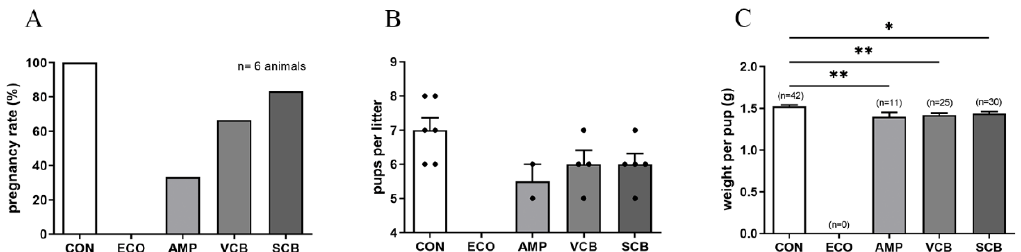
Figure 5. C. butyricum and its culture supernatant restore reproduction outcome in E. coli -induced endometritis mice. ( A ) Pregnancy rate refers to the percentage of the number of pregnant mice to the number of mated mice in each group (the number of mated mice in each group = 6 animals). ( B ) Pups per litter refers to the total number of pups born in each group divided by the number of maternal mice in the group. The number of black dots indicates the number of pups. ( C ) Weight per pup is the total weight of pups in each group divided by the number of pups in that group. * p < 0.05 and ** p < 0.01 are significantly different from the CON group.